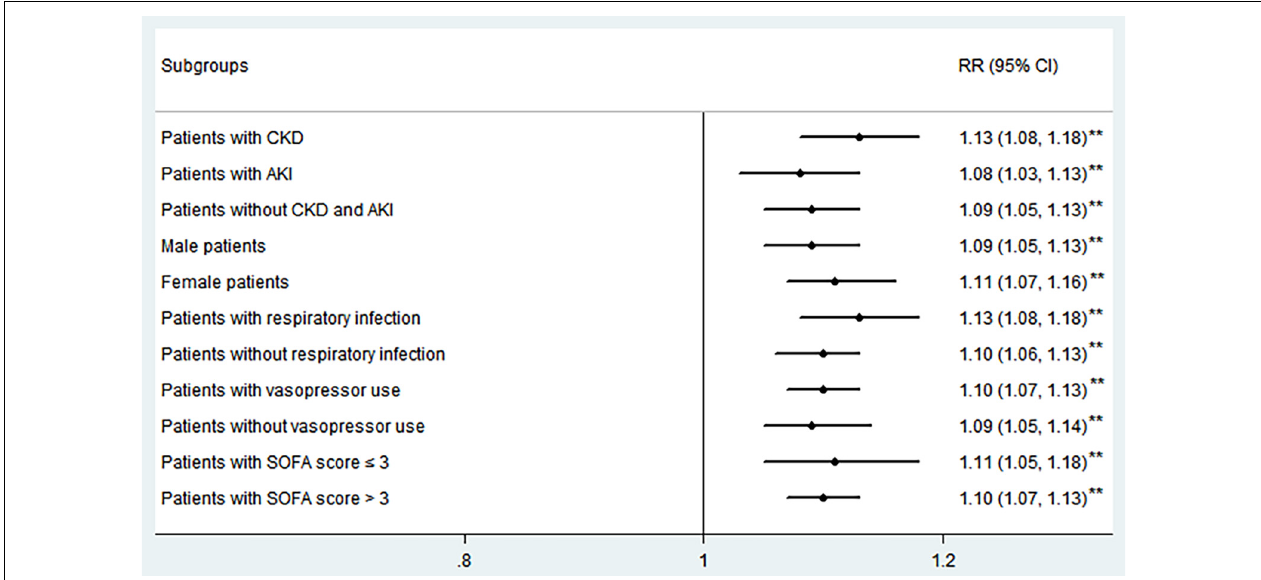
FIGURE 4 | Adjusted risk ratio (RR) of serum Pi for in-hospital mortality in different septic subgroups. ** p < 0.01; CKD, chronic kidney disease; AKI, acute kidney injury. SOFA score, sequential organ failure assessment score.